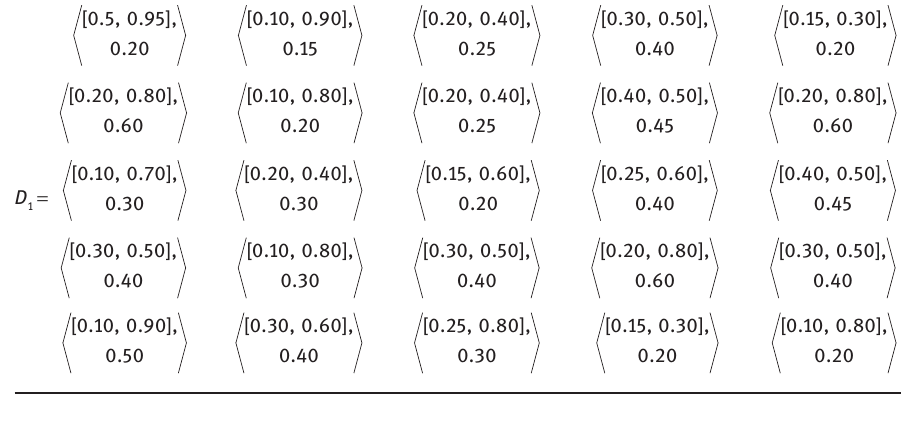
Table 8: Decision Matrix 2.